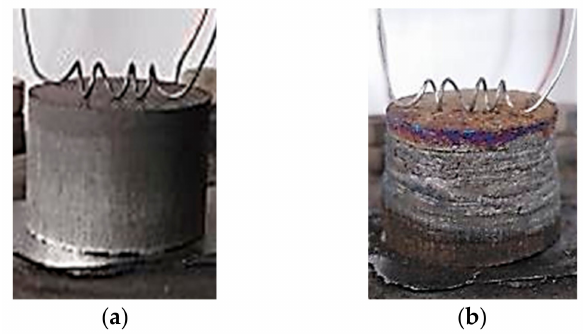
Figure 9. Photographs of Al-Ti-B specimen: ( a ) before combustion; ( b ) after combustion synthesis. A typical XRD pattern of the planetary milling combustion product obtained from the powder mixture is presented in Figure 10. The results of the XRD analysis are gathered in Table 5.